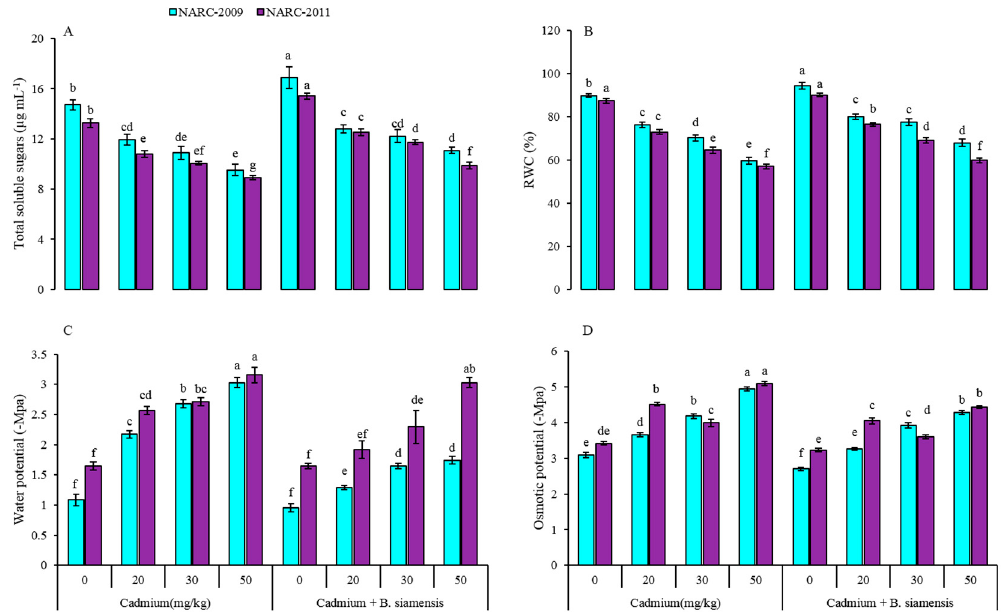
Figure 3. Effect of seed inoculation with Bacillus siamensis on total soluble sugars ( A ), relative water content (RWC) ( B ), water potential ( C ), and osmotic potential ( D ) of two wheat varieties under Cd stress. Data are expressed as the means of three replicates. Bars show ± SD and different letters show a significant difference among treatments at 0.05 level.